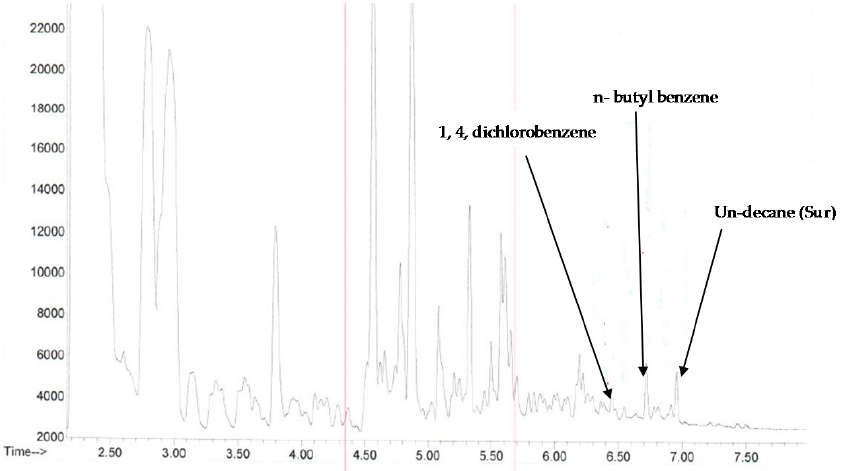
Figure 14. FID-GC from 15 g of LDPE.